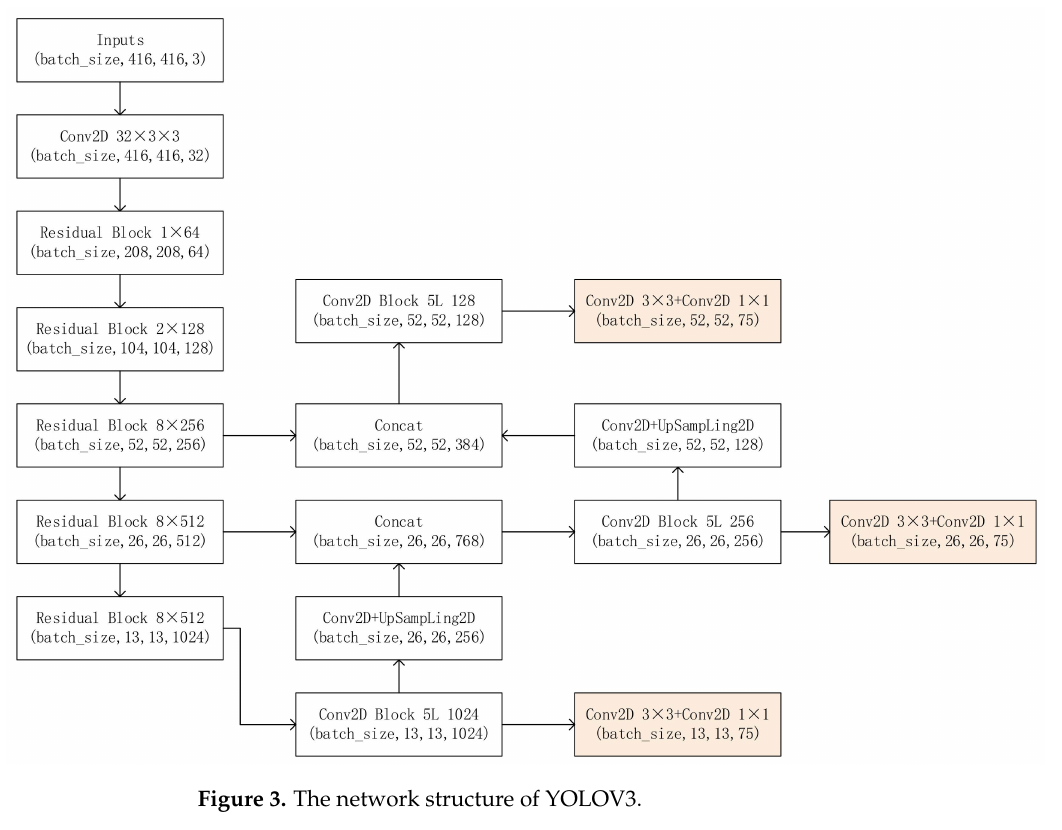
Figure 3. The network structure of YOLOV3.